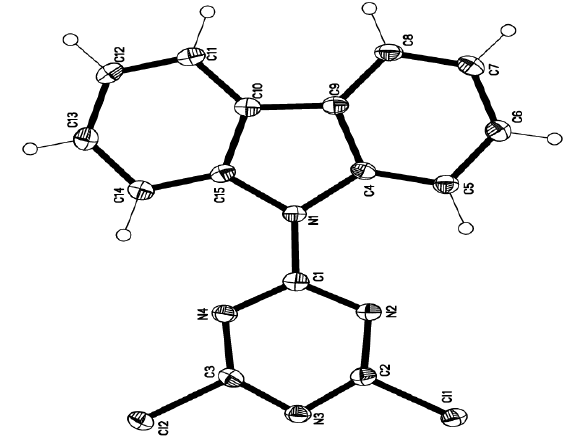
Figure 2. Molecular structure of ( 3 ). Anisotropic displacement ellipsoids are drawn at the 50% probability level.